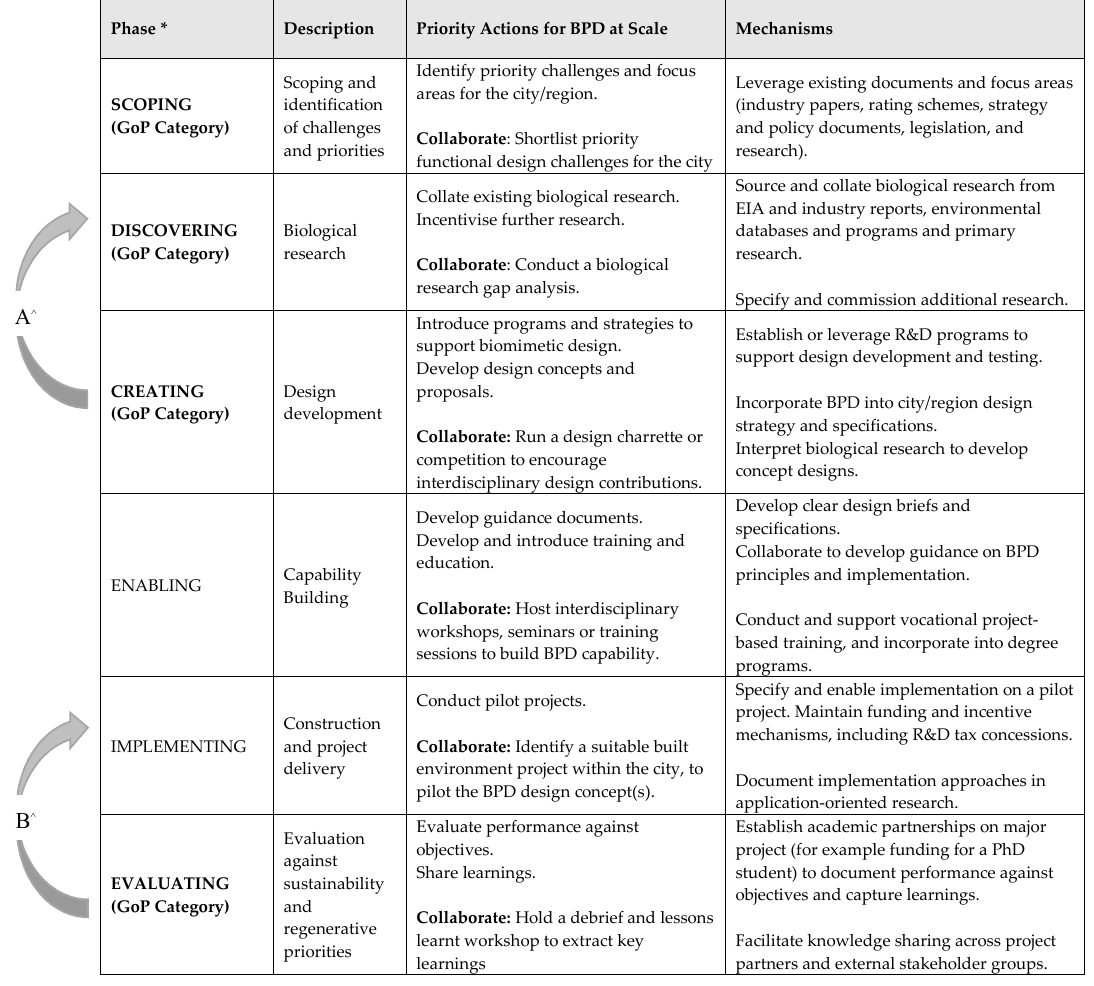
Figure 1. Priority capability-building actions for industry, government, and academia sectors to advance biomimetic place-based design (BPD) at-scale. * Bolded text indicates original GoP phases [8]. ˆ Iterative linkages: A = During and after the ‘Creating’ phase, it may become evident that further investigation of the biological sources is required. B = Evaluation should occur both before and after implementation to support the identification of gaps and opportunities for